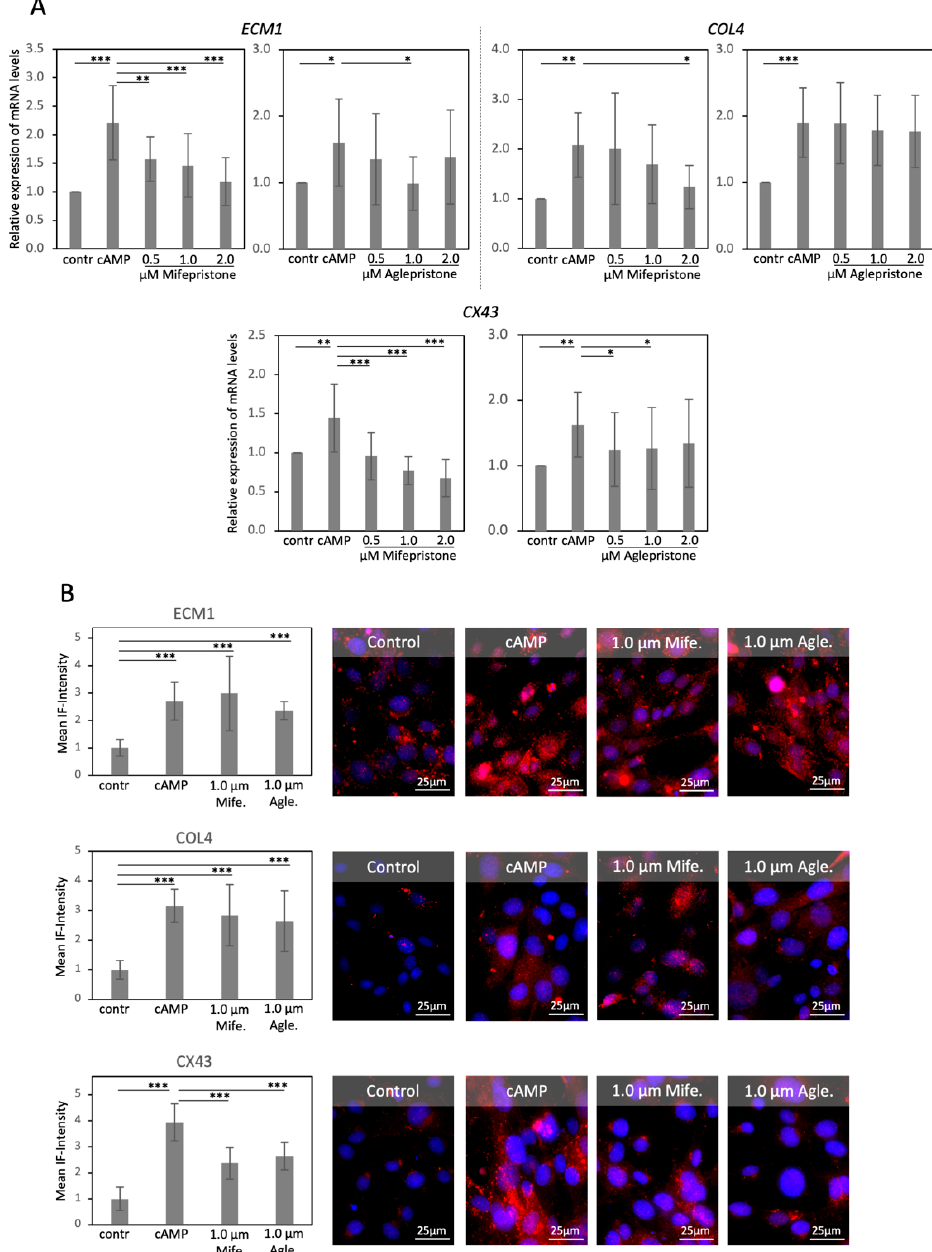
Figure 4. Antigestagen-mediated effects on the expression of extracellular matrix protein (ECM) 1, collagen (COL) 4, and connexin (CX) 43 in DUS cells. ( A ) Relative gene expression of ECM1 , COL4 , and CX43 , as determined by semi-quantitative real-time (TaqMan) PCR in DUS cells decidualized with 0.5 mM cAMP for 72 h and consequently treated with increasing dosages of mifepristone or aglepristone for 6 h. ( B ) Quantification of protein expression of the selected factors as determined by immunofluorescence (IF) staining and corresponding representative figures. Effects of treatments in the transcriptional and protein availability of investigated factors were evaluated with a parametric one-way ANOVA, revealing: ( A ) p < 0.0001 and p = 0.0126 for ECM1 in response to mifepristone or aglepristone, respectively; p = 0.0009 and p < 0.0001 for COL4 , respectively; p < 0.0001 and p = 0.004 for CX43 , respectively; in ( B ) p < 0.0001 for the mean IF-intensity of all the evaluated markers. The ANOVA tests were followed by a Tukey-Kramer multiple-comparisons test. Numerical data are presented as mean ± standard deviation (SD). Bars with different asterisks differ at: (*) p < 0.05, (**) p < 0.01, (***) p < 0.001. Mife. = Mifepristone, Agle. =